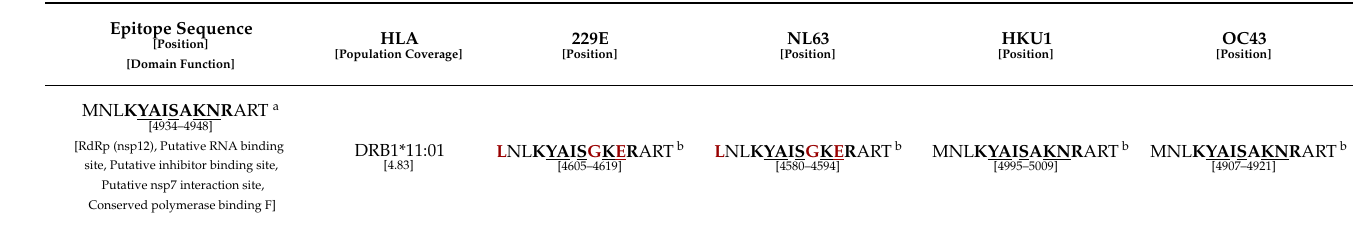
Table 9. 15-mer epitopes (9-mer core epitope is highlighted in bold) originated from ORF1ab with identical TCR contact residue between SARS-CoV-2 and Human CCC identified through IEDB Conservancy Analysis Tools, along with information on HLA that binds, population coverage, position and previous IEDB report on the binding. The TCR contact residue (highlighted in bold and underlined) of HLA Class II is located in position 2, 3, 5, 7 and 8 within the 9 mer core. The residue difference across the sequence is indicated with red color